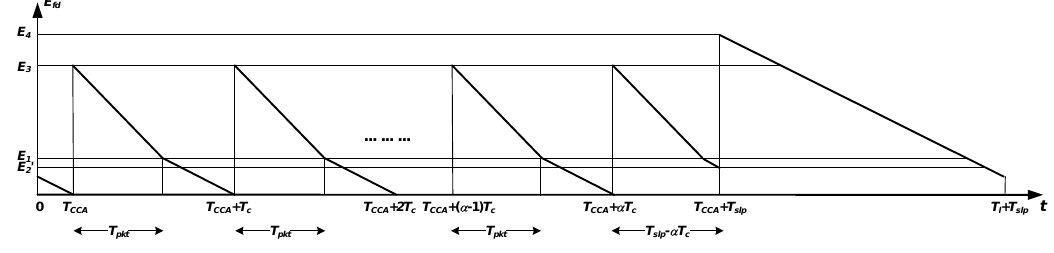
Figure 5. Evolution of E fd in terms of the transmitter-receiver asynchrony, for T slp ≥ α T c + T pkt